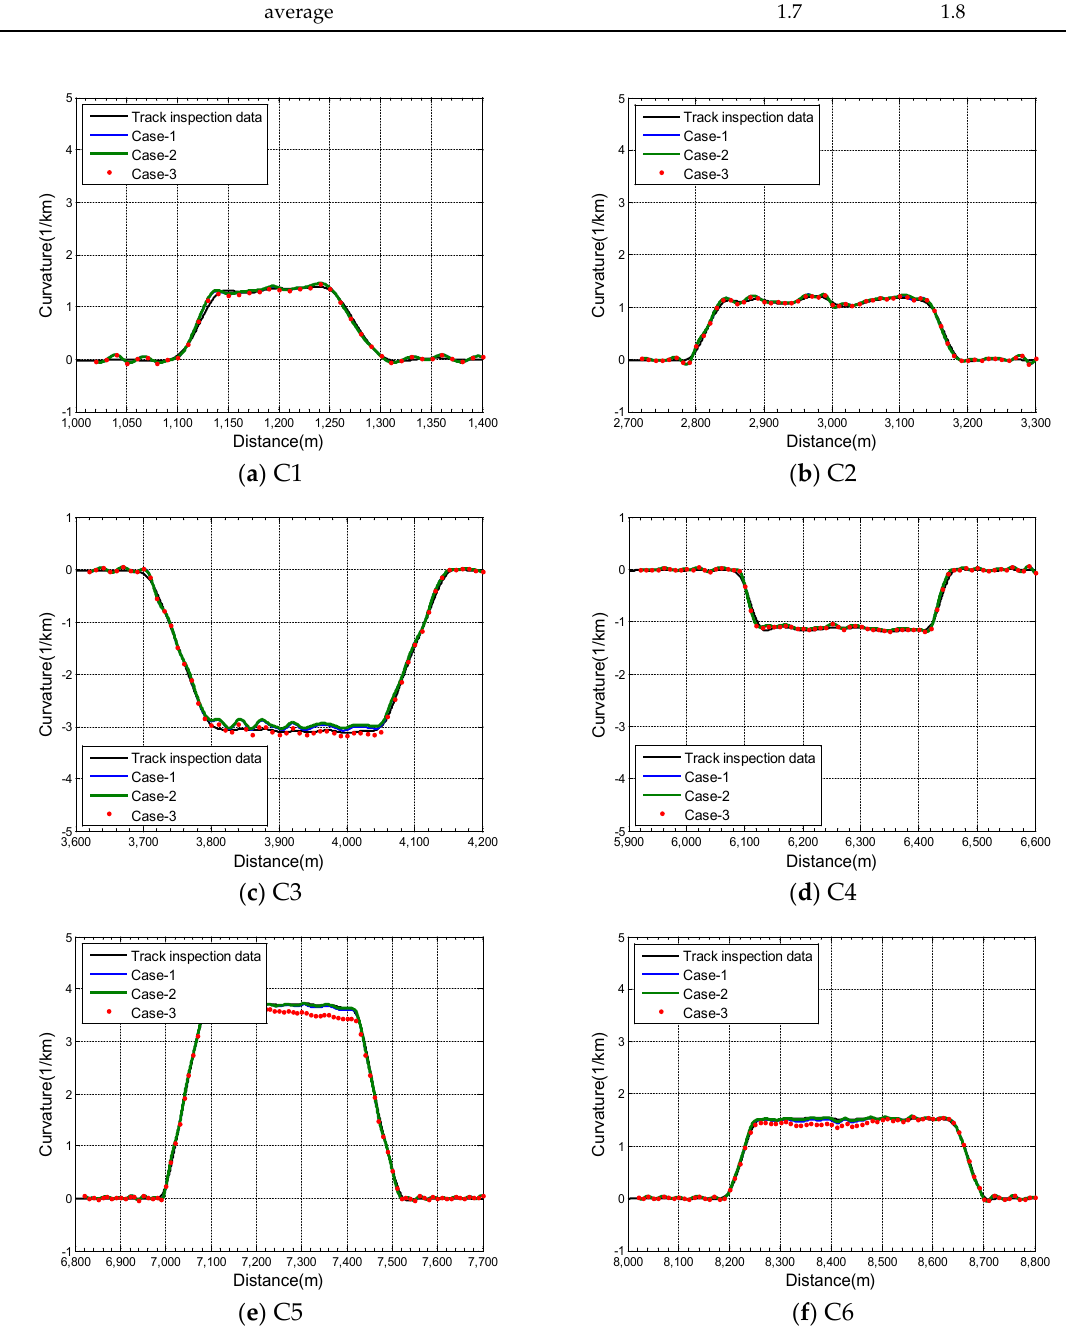
Figure 9. Curvature simulation result for each curve.